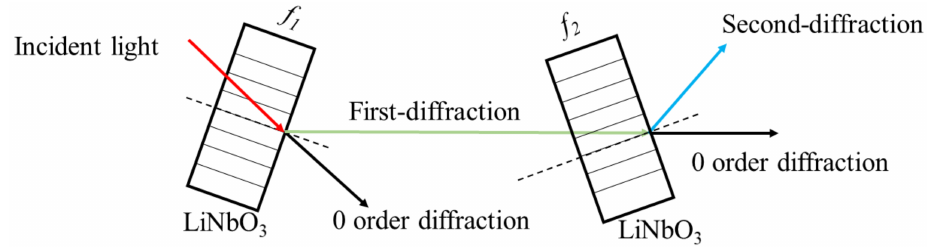
Figure 2. Working principle of double crystal cascade acousto-optic frequency